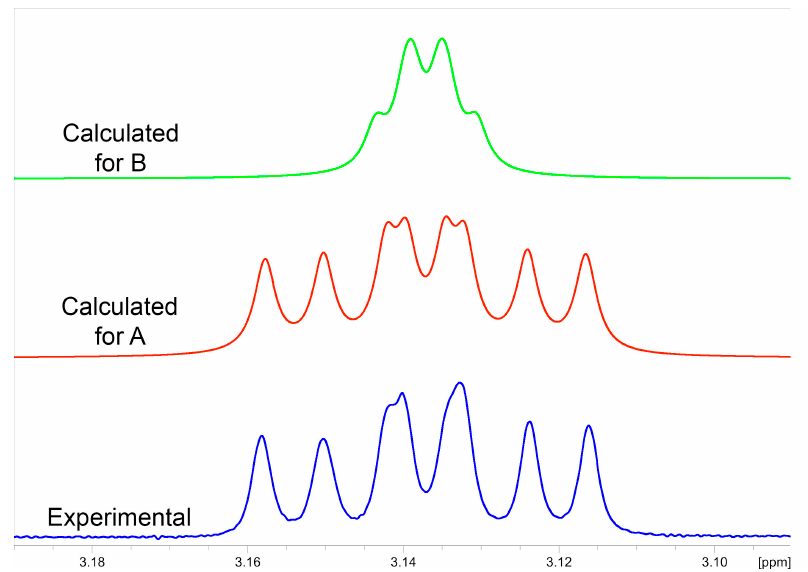
Figure 4. Comparison of the experimental 1 H NMR multiplet at 3.13 ppm of monicanol (blue) with simulated multiplet patterns using scaled calculated coupling constants for diastereomer A (red, scaled coupling constants 10.90, 9.34 and 4.52 Hz, monicanol) and compound B (green, scaled coupling constants 3.00, 2.16 and 2.63 Hz, 2- epi -monicanol).